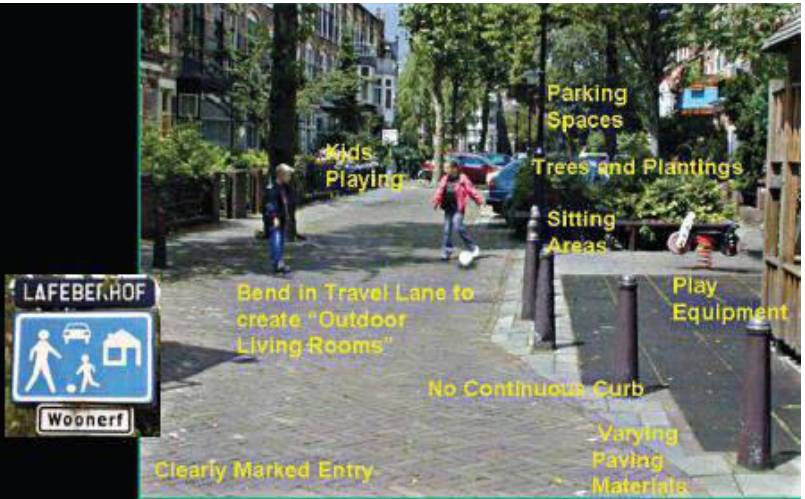
Figure 2 Principles of woonerf design by Appleyard and Cox (2006, p.31; Collarte,